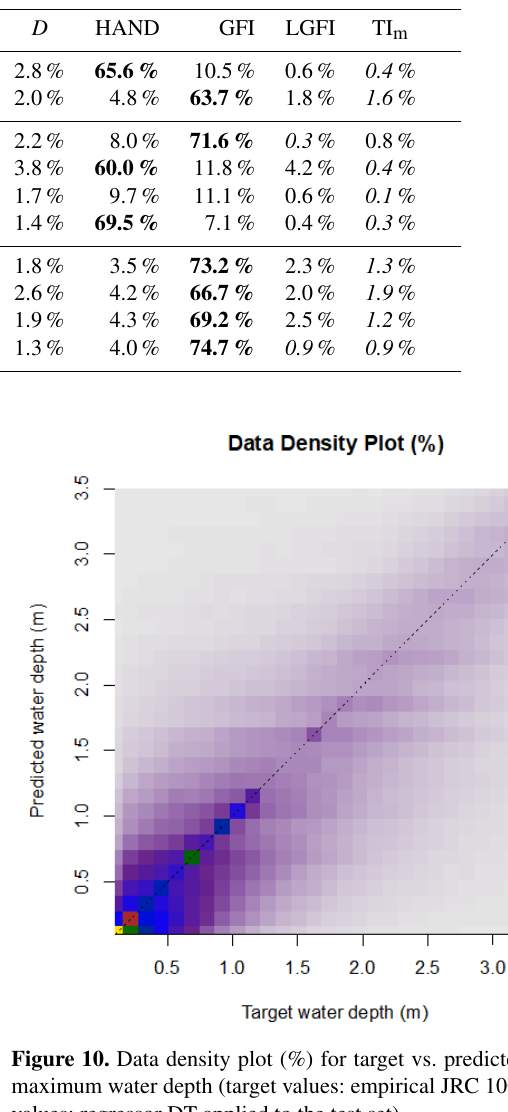
Table 3. Gini importance of the selected input features computed for the DTs trained in phase 4; the highest value for each DT is highlighted in bold, the lowest in italic.